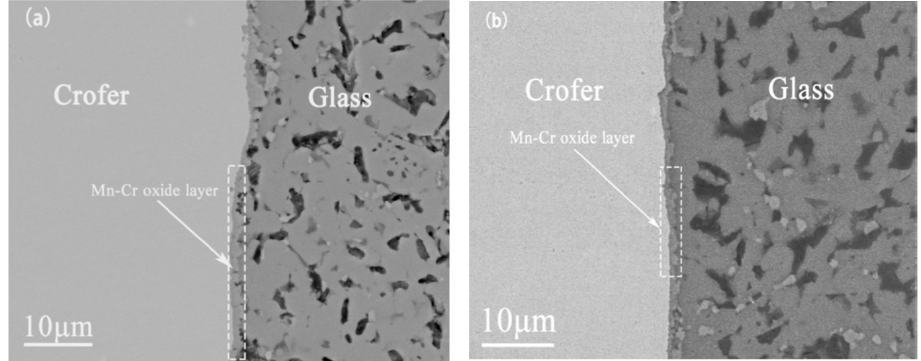
Figure 7. Reaction images of sealed glass and interconnects at different time lengths: ( a ) Reaction images at 100 h. ( b ) Reaction images at 500 h. Reprinted with permission from Ref. [27].